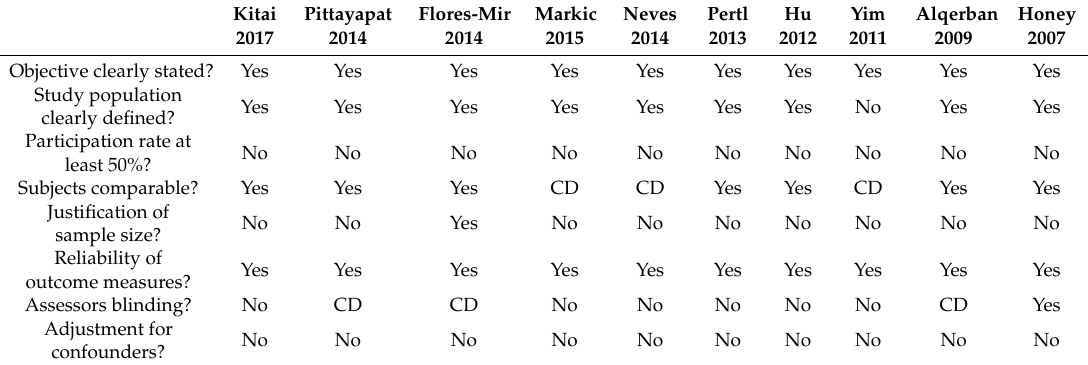
Table 7. Methodological quality appraisal of studies regarding dental anatomy evaluation.